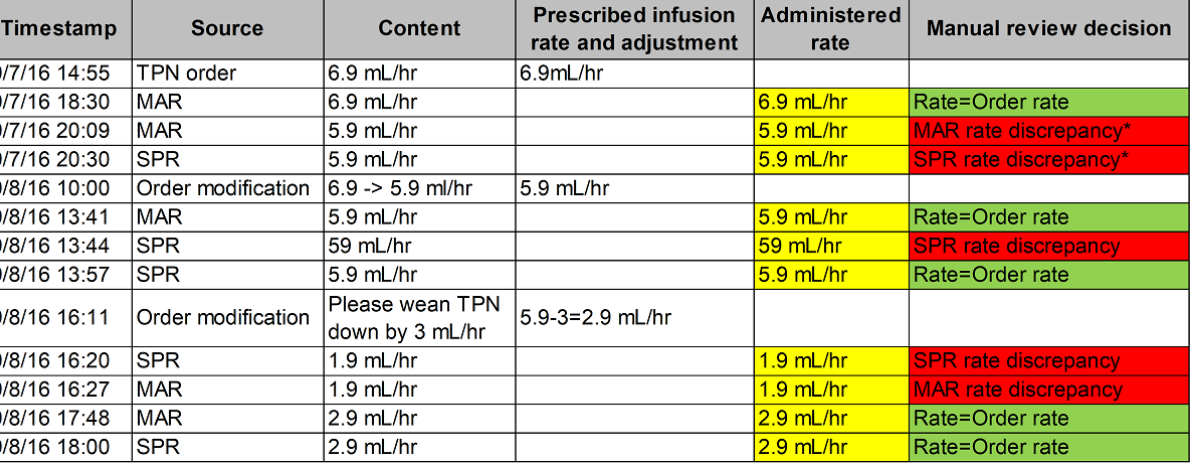
Figure 1. An example of chronological ordering of medication use data and medication administration records or smart pump record discrepancies identified by manual review. The discrepancy occurred because the order modification was placed over 30 min after the MAR or SPR, which did not meet the institutional expectations even if the administration was correct. MAR: medication administration records; SPR: smart pump record; TPN: total par-enteral